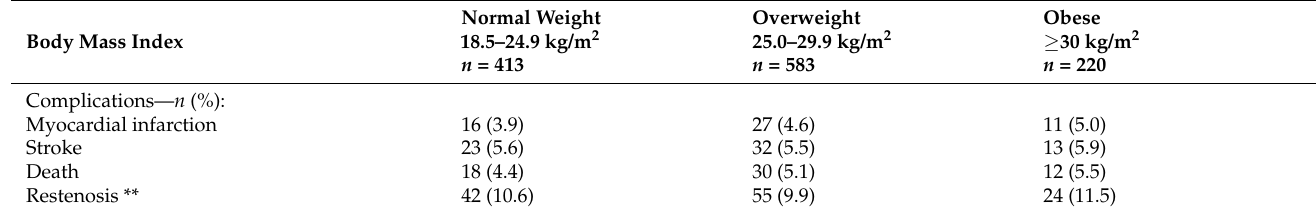
Table 3. Late adverse outcomes after carotid endarterectomies